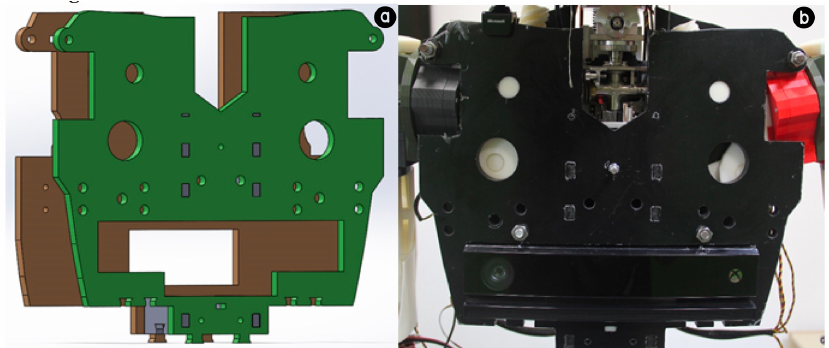
Figure 5. Development and integration of the SA sensors in the torso designed for FACE; ( a ) Computer Assisted Design (CAD) project of the FACE torso; ( b ) realisation of the torso.